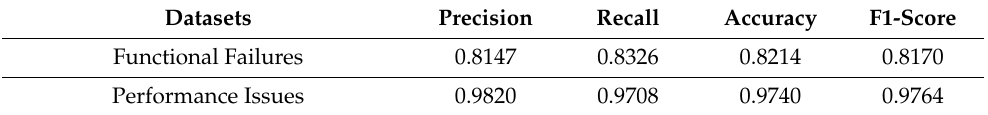
Table 6. Performance on functional failure and performance failure detection.